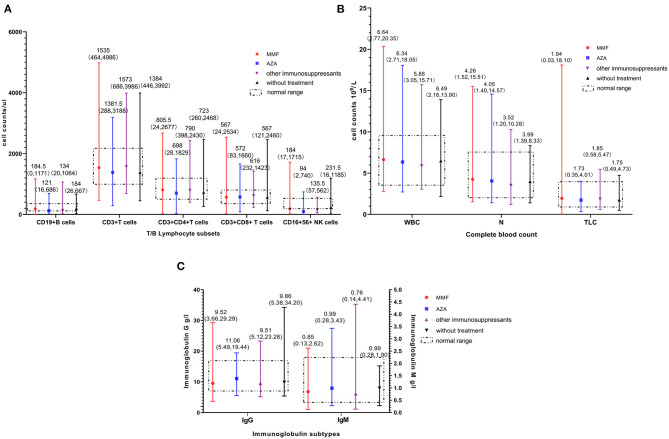
Immune cell count and immunoglobulin level in patients. (A) Distribution of T/B lymphocyte subsets. (B) Distribution of complete blood count. (C) Distribution of different immunoglobulin subtype. Numbers on each vertical line indicate the median (range) value. MMF, mycophenolate mofetil; AZA, azathioprine; WBC, white blood cell; N, neutrophil; TLC, lymphocyte.